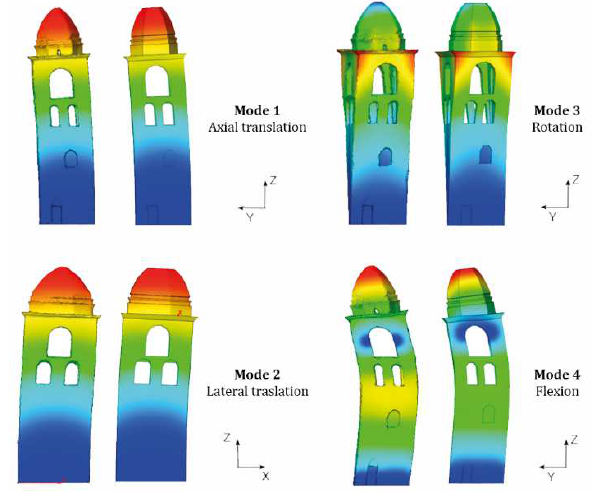
Figure 12 - Modal forms of the two